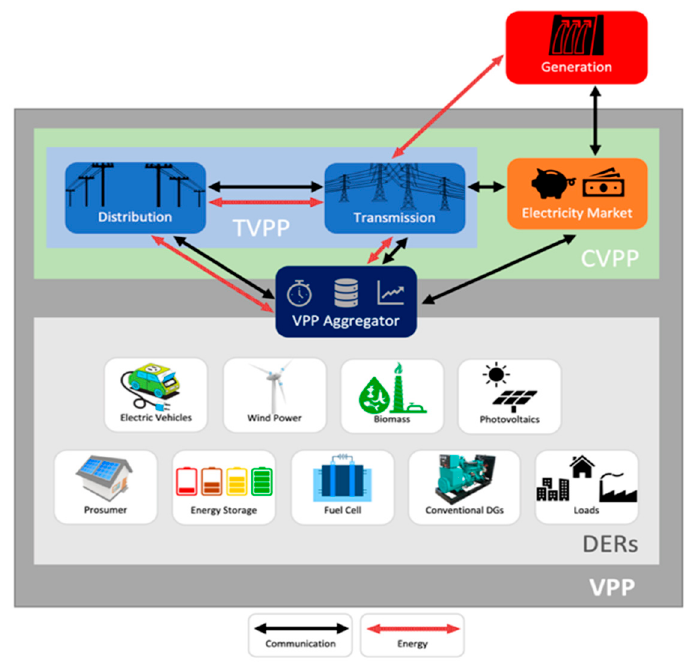
Figure 2. Illustration of the Virtual Power Plant.